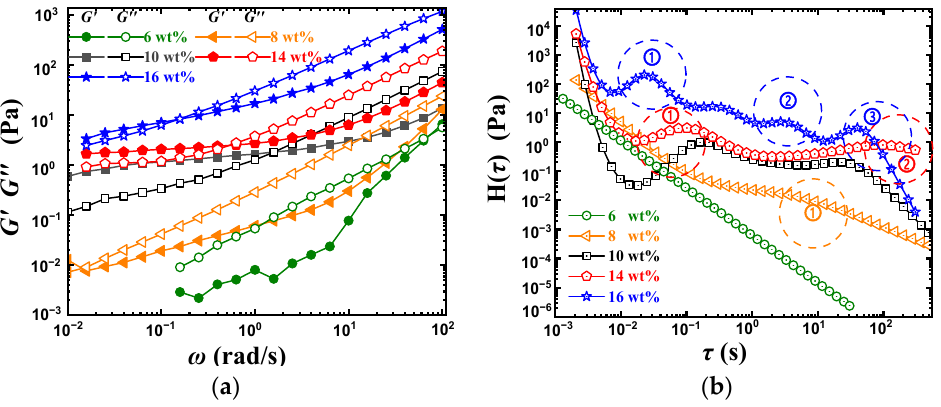
Figure 7. Dynamic rheological behavior and the corresponding relaxation spectrum of PVA solution with concentrations. ( a ) Dynamic rheological behavior. ( b ) Relaxation spectrum. In addition, with the increase in concentration in the range of 6–16 wt%, the intersec- ω has a trend of first right shift and then left shift. The parameters of PVA tion point H ξ solutions with different concentrations obtained by Equation (6) are listed in Table 1. Table 1. Mesh size of PVA solution with different concentrations. wt%